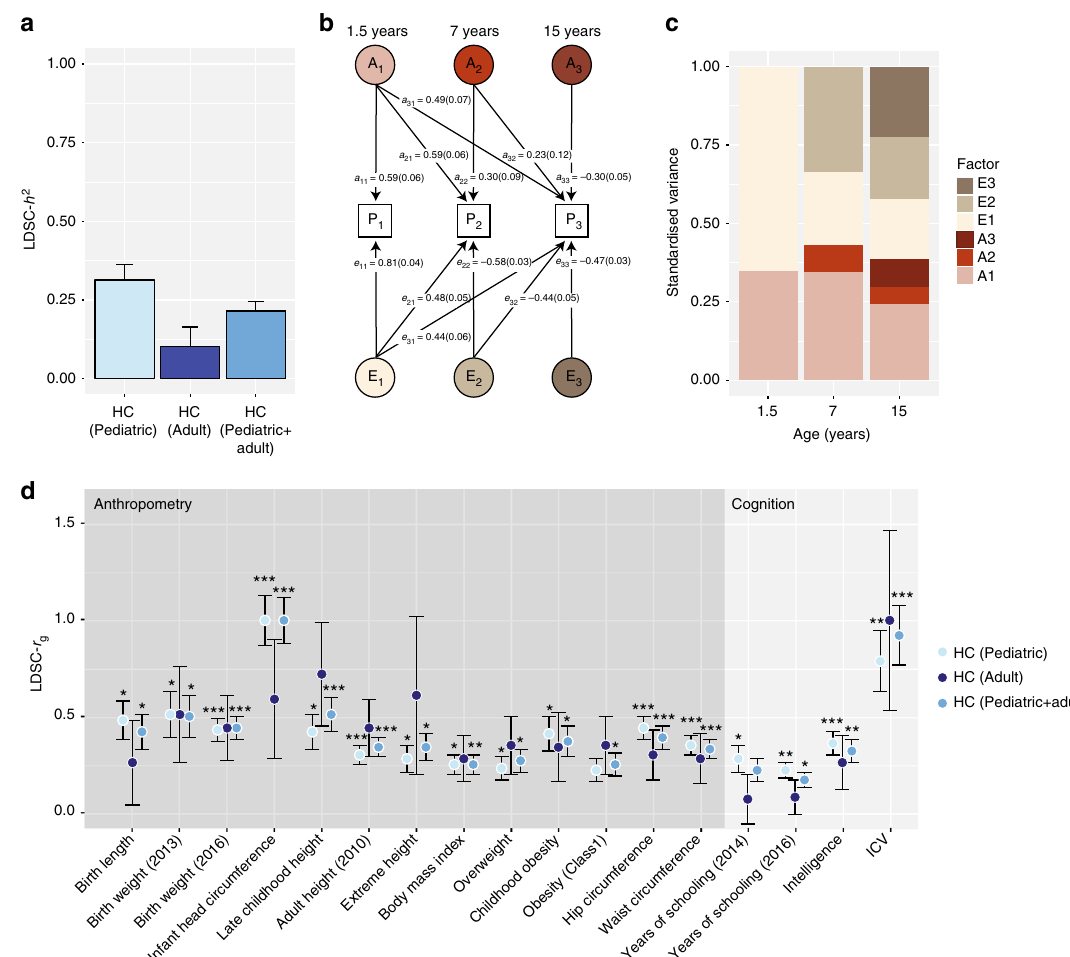
Fig. 5 Genetic architecture of head circumference (HC). a Linkage-disequilibrium score SNP-heritability (LDSC- h 2 ) for HC (Pediatric), HC (Adult) and HC (Pediatric + adult) meta-analyses. b Genetic-relationship matrix structural equation modeling (GSEM) of head circumference during development: Path diagram of the full Cholesky decomposition model using longitudinal head circumference measures from ALSPAC (1.5 years ( N = 3945), 7 years ( N = 5819), and 15 years ( N = 3406)). Phenotypic variance (P1, P2, P3) was dissected into genetic (A1, A2 and A3) and residual (E1, E2 and E3) factors. Observed measures are represented by squares and latent factors by circles. Single-headed arrows de fi ne relationships between variables. The variance of latent variables is constrained to unit variance. c Standardized genetic and residual variance components for head circumference during development. Variance components were estimated using the GSEM model as shown in ( b ). d Linkage-disequilibrium score correlation (LDSC- r g ) for HC (Pediatric), HC (Adult) and HC (Pediatric + adult) and 235 phenotypes: 17 genetic correlation estimates passing a Bonferroni threshold ( p < 0.00014) are shown with their standard errors. *** p < 10 − 8 ; ** p < 10 − 5 ; * p <